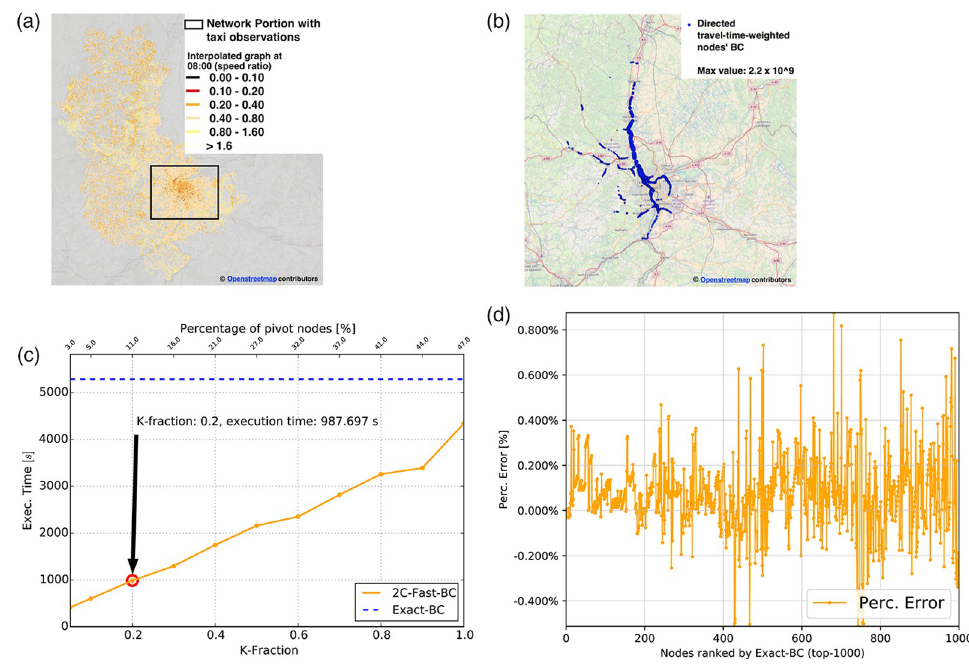
Fig 10. The interpolated dynamic taxi graph: Median-speed-to-max-speed ratio at different hours of the day. (a) KNR-interpolated graph at 08:00 (b) Top-1000 nodes’ BC values at 08:00 (c) Execution time of W2C-Fast-BC vs Brandes- BC at 08:00 (d) KNR-interpolated top-1000 BC percentage error at 08:00.